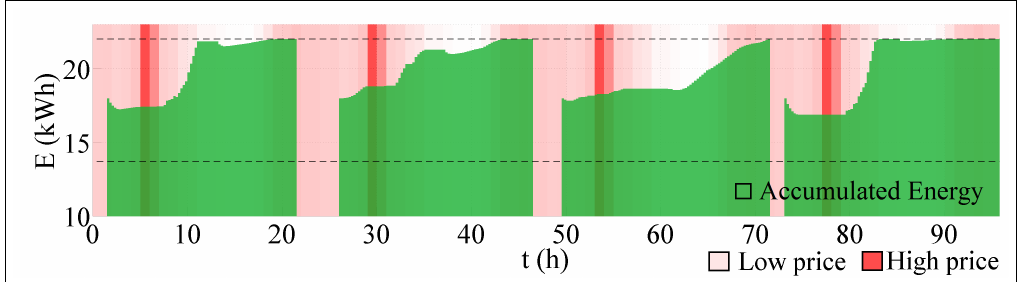
Figure 9. The temperatures for the first 96 simulation hours.